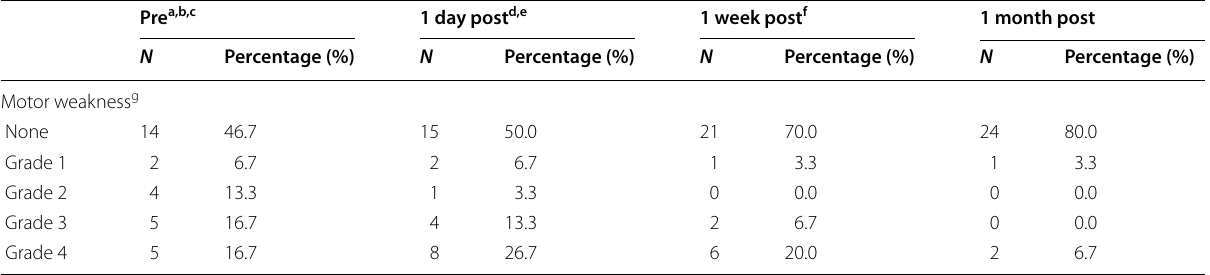
Pre, preoperatively; Post, postoperatively; N , number of patients a,b,c Pre vs. 1 day p